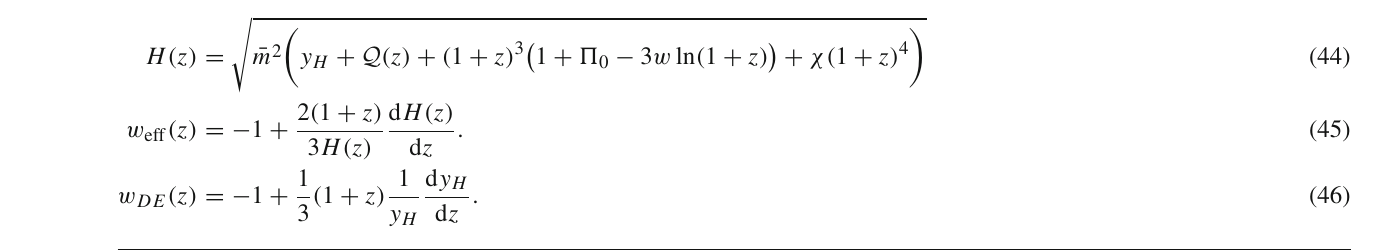
Fig. 1 Comparison of the Hubble parameter H ( z ) versus z , of the dark energy equation of state parameter w DE versus z and of the effec- tive equation of state parameter w eff versus z . The red curves corre- spond to the mimetic f ( R , T ) model in a Universe filled with colli-